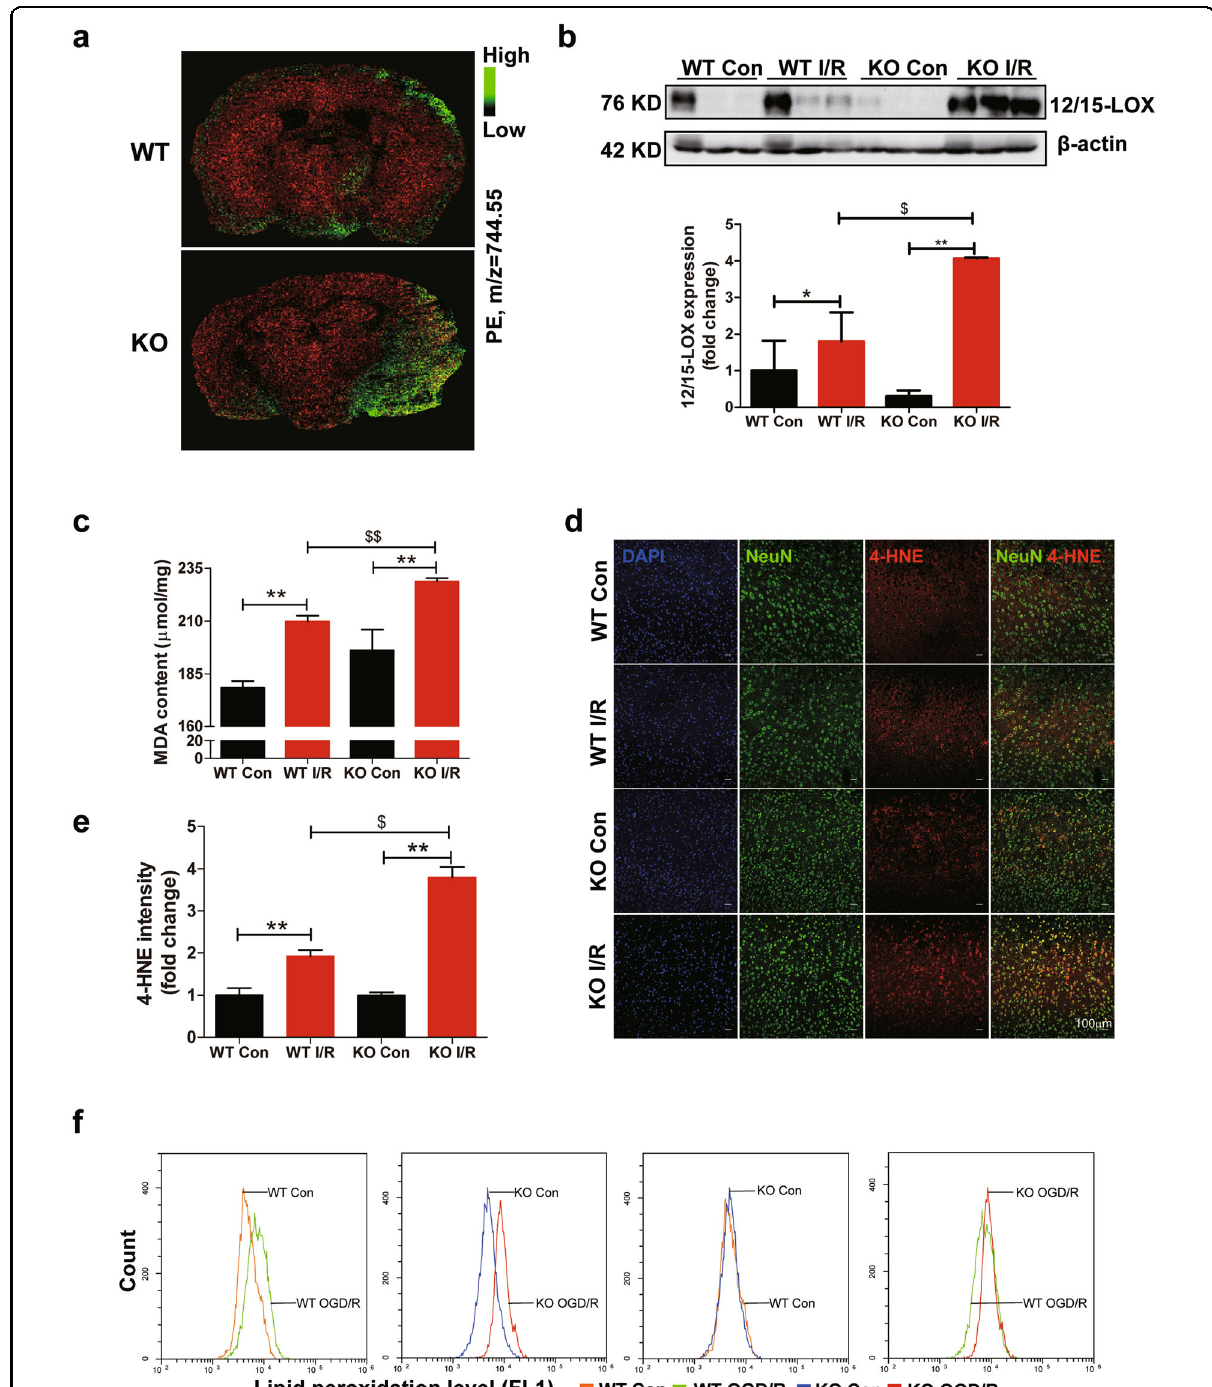
Fig. 4 Ablation of FtMt promotes lipid peroxidation in I/R brains. a MSI heat maps for the distribution of PE ( m/z = 744.55, green) in wild-type (WT) and Ftmt -knockout (KO) mouse brains after ischaemic stroke. b Western blot analysis of 12/15-LOX in WT and KO mice after MCAO (90 min) and subsequent reperfusion (24 h) ( n = 6). c The mouse brain MDA content was measured. The data are expressed relative to the mean value in the WT control (Con) group ( n = 5). d Representative immuno fl uorescence images of 4-HNE (red) and Neun (green). e Quanti fi cation of 4-HNE fl uorescence intensity ( n = 3). f Flow cytometry analysis of OGD/R-induced C11-BODIPY (581/591) oxidation in primary cultured WT and KO neurons. The data shown are representative of two independently performed experiments. The results are presented as the mean ± SEM. */ $ P < 0.05, ** /$$ P <